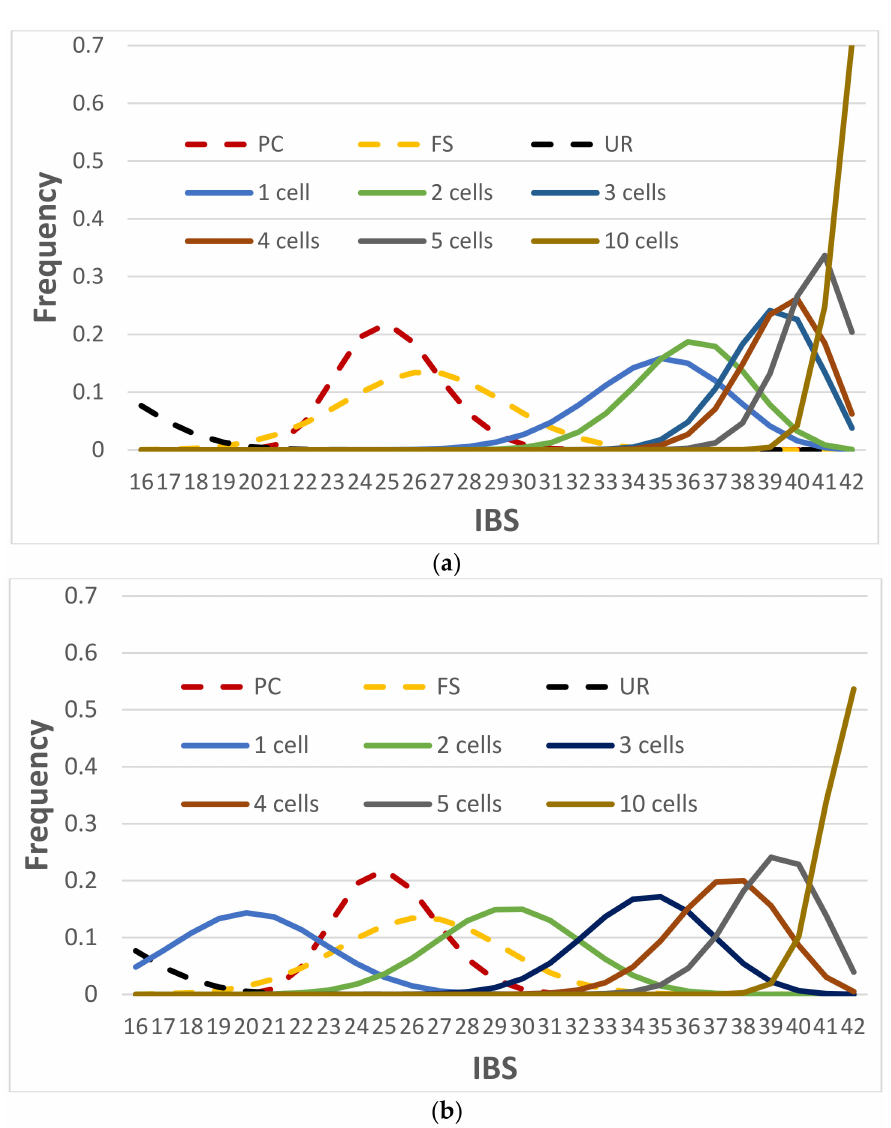
Figure 3. IBS distributions of unrelated and related pairs (UR, PC, and FS, in dotted lines) and pairs of the true profile versus the consensus profile with a given number of cells (in solid lines) based on ( a ) diploid cells and ( b ) haploid cells. D = 0.2; e = 0.01; 1,000,000 simulations for each distribution. The IBS of “ n cell(s)” is the IBS between true genotypes and the consensus genotypes from n cell(s). These distributions are based on 21 GlobalFiler markers and thus the maximum IBS is 42. The consensus profile might contain missing alleles, and these missing alleles were excluded in counting